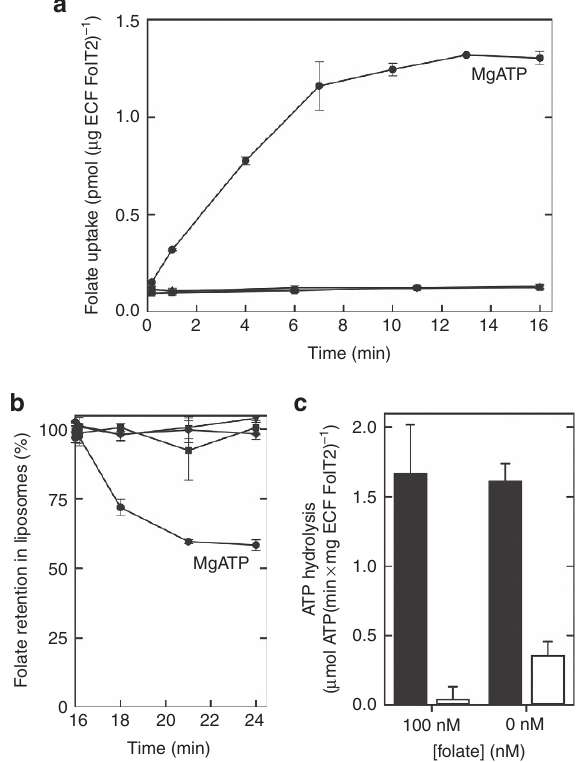
Figure 2 | Transport and ATPase activity of ECF–FolT2. ( a ) Transport activity of ECF–FolT2 in proteoliposomes loaded with 5mM of MgATP (circles), 5mM MgADP (inverted triangles), 5mM MgAMP–PNP (triangles) or 5mM Na 2 ATP plus 5mM EDTA (squares). ( b ) Efflux activity of ECF–FolT2 from proteoliposomes loaded with 5mM of MgATP, after accumulation of radiolabelled folate for 16min. At t ¼ 16min, 5mM of MgATP (circles), 5mM MgADP (inverted triangles), 5mM Na 2 ATP plus 5mM EDTA (squares) or 100 m M non-radiolabelled folate (diamonds) was added to the reactions. ( c ) ATPase activity of ECF–FolT2 reconstituted in proteoliposomes (black bars) and background ATPase activity by empty liposomes (white bars). When indicated, folate was present both in the lumen of the liposomes and in the environment. The error bars show the s.d.’s from three independent